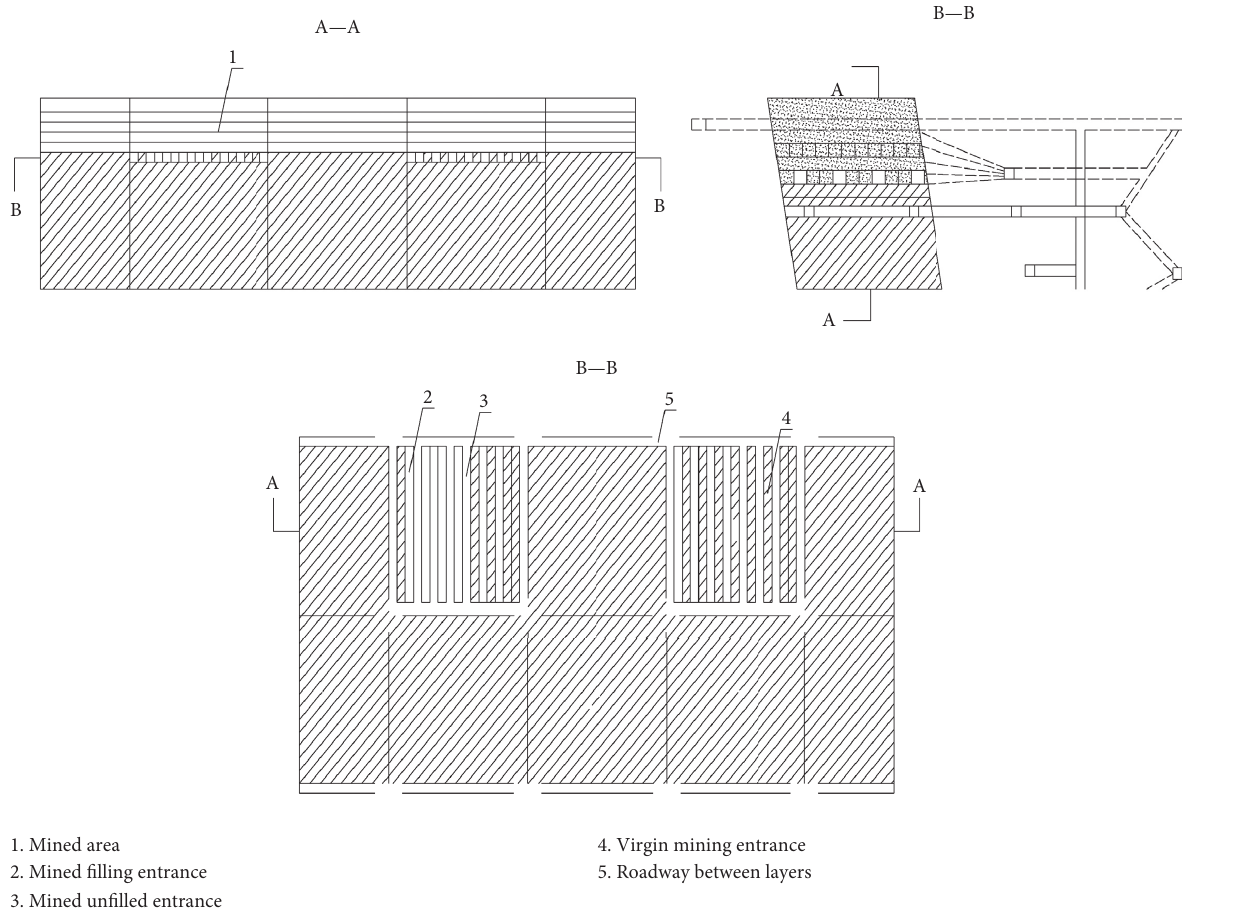
Figure 5: The mining approach with large-section unloading